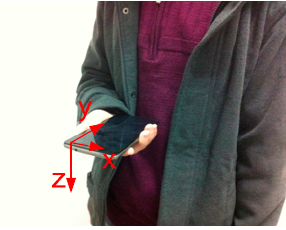
Figure 2. Handheld posture of mobile phone.